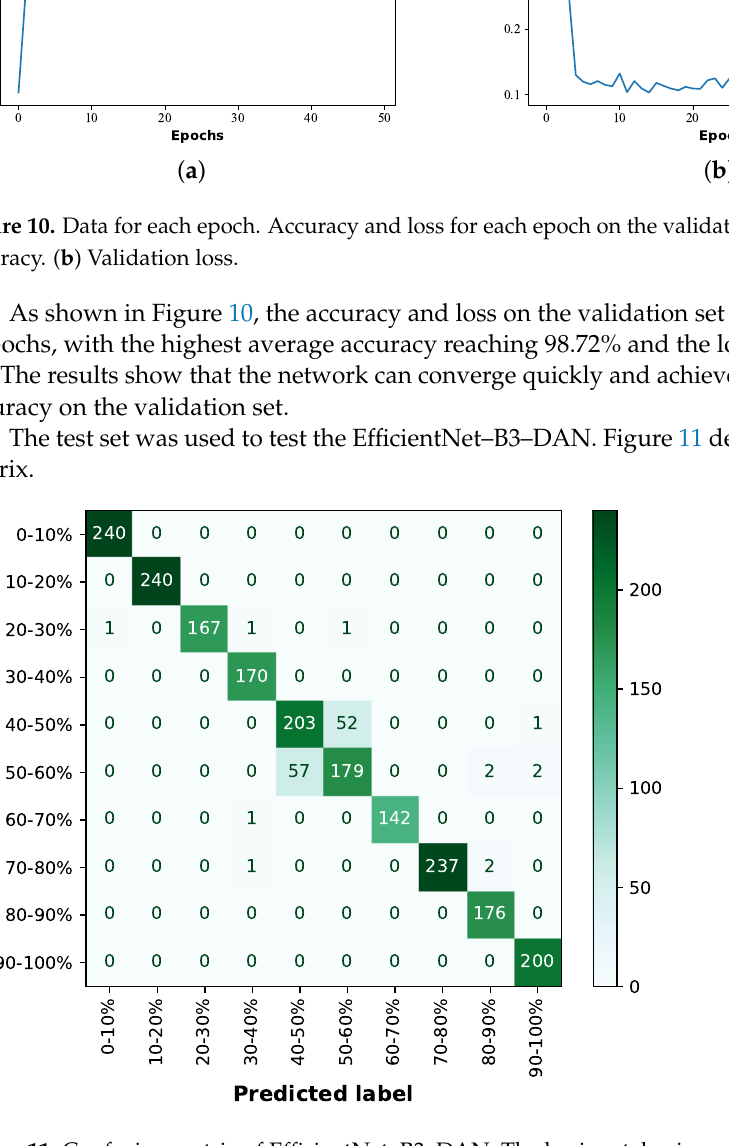
Figure 11. Confusion matrix of EfficientNet–B3–DAN. The horizontal axis represents the predicted labels for each category, and the vertical axis represents the true labels for each category. Each grid represents the number of classes predicted to be another class. The diagonal cells represent the number of correct